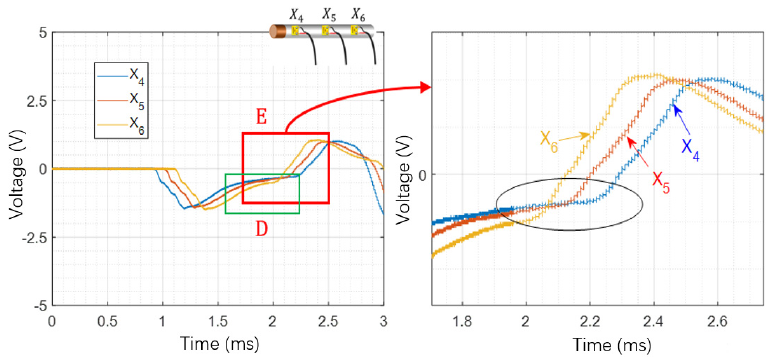
Figure 5. Comparison of three transmitted waveforms.